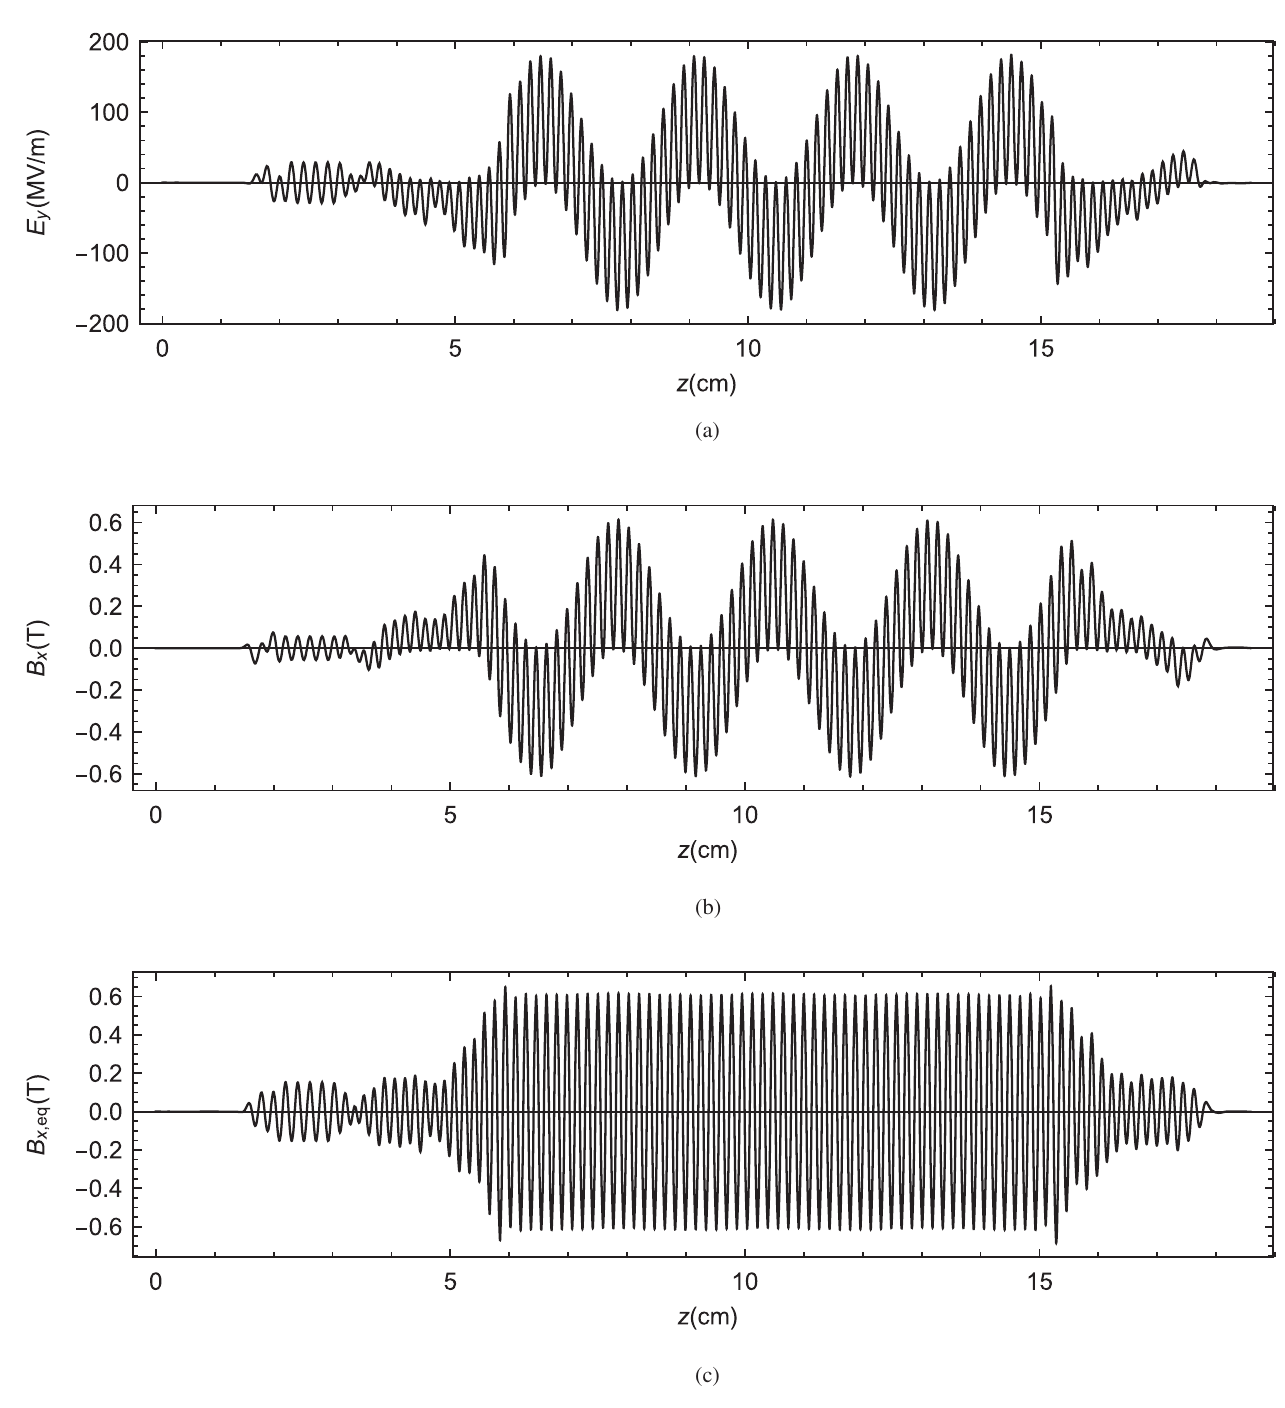
FIG. 31. Fields seen by the electron beam when injected with ϕ rf ¼ 112 deg, adapted from Toufexis et al.